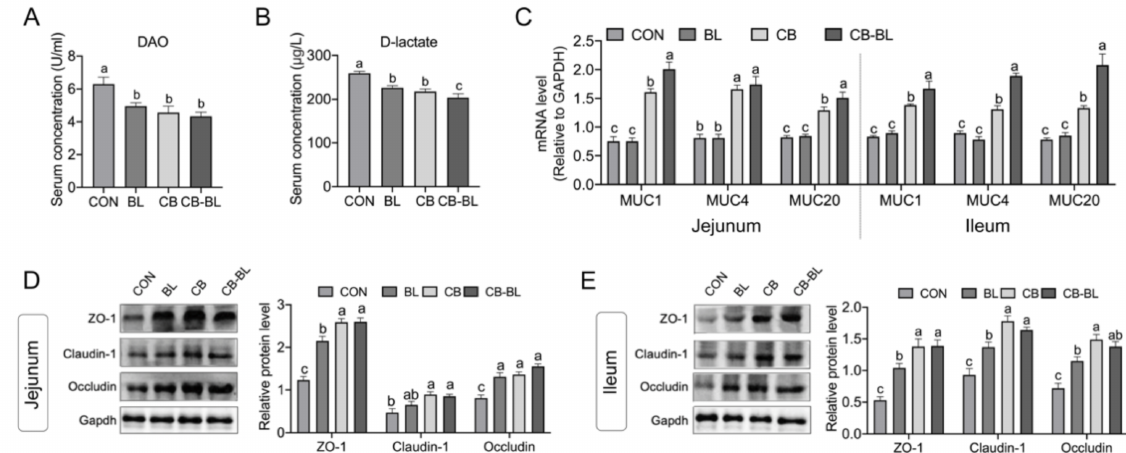
Figure 2. Effects of C. butyricum ZJU-F1 on intestinal barrier function. ( A – B ) The concentration of diamine oxidase ( A ) and D-lactic acid ( B ) in serum of piglets fed each diets. ( C ) qRT-PCR quantified muc1 , muc4 , and muc20 mRNA abundance in jejunum (left) and ileum (right). The results were presented relative to those of Gapdh. ( D – E ) Western blot analysis of the expression of tight junction proteins in jejunum ( D ) and ileum ( E ). The right panel shows the relative levels quantified by densitometry and normalized to Gapdh. The data are expressed as the mean ± SEM, n = 6, biological replicates; bars with different small capital letters are statistically different from one